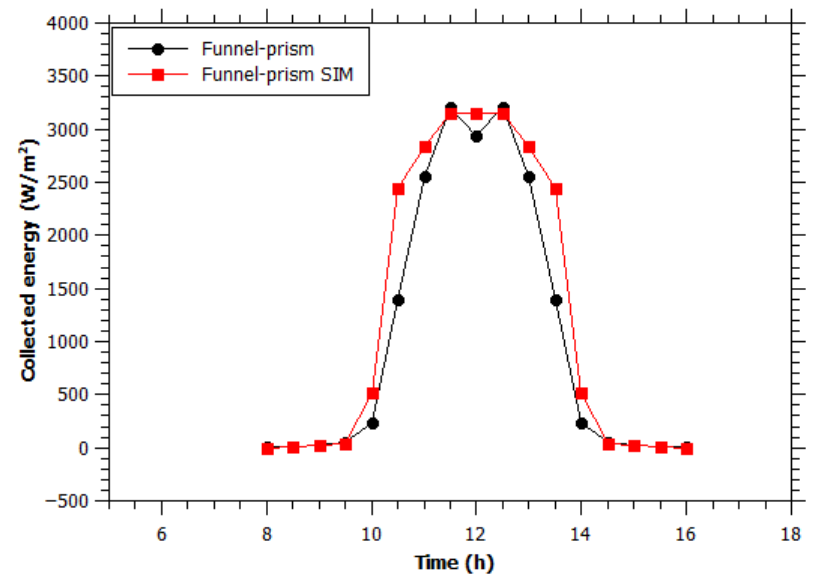
Figure 8. Comparison of experimental(Funnel-prism) and simulated data (Funnel-prism SIM) for the complete